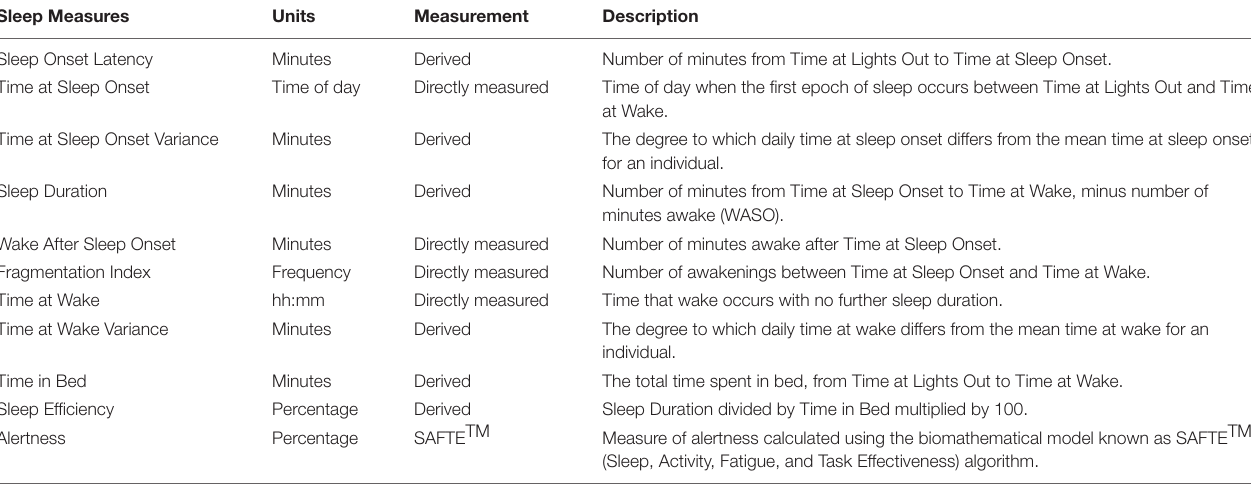
TABLE 1 | Summary of derived and direct sleep measures from the Readiband TM (Fatigue Science, Canada) device. Sleep Measures